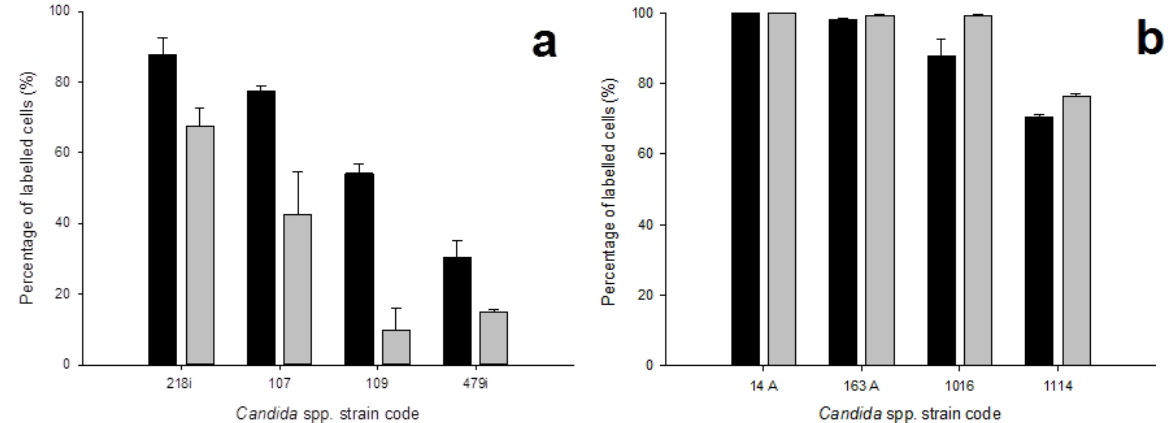
Figure 4 - Citometry efflux assay of Candida spp. strains using R6G as fluorescent substrate in the presence and absence of glucose. ( a ) Flow citometry conducted with clinical isolates that were chemosensitized by FK506. ( b ) Flow citometry assay of clinical isolates that retained resistance phenotype using FK506. Black bar = no glucose; Gray bar = with glucose. This experiment represents average of triplicate.